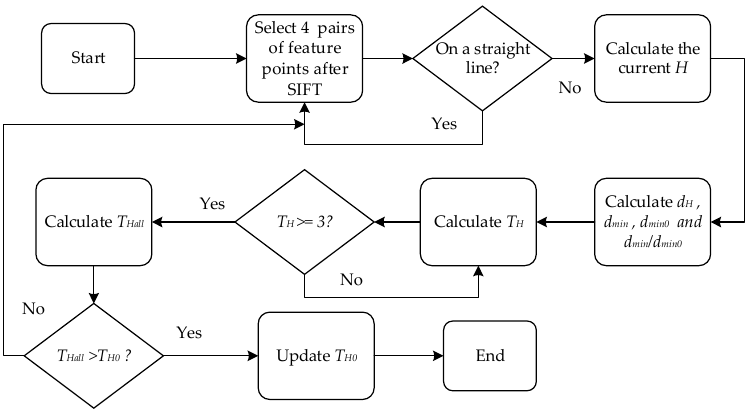
Figure 2. IIR algorithm flow chart. The goal of IIR algorithm is to obtain the optimal Homography matrix, and then to realize the accurate coordinate space transformation; that is, to delete and select the correct feature matching pairs.